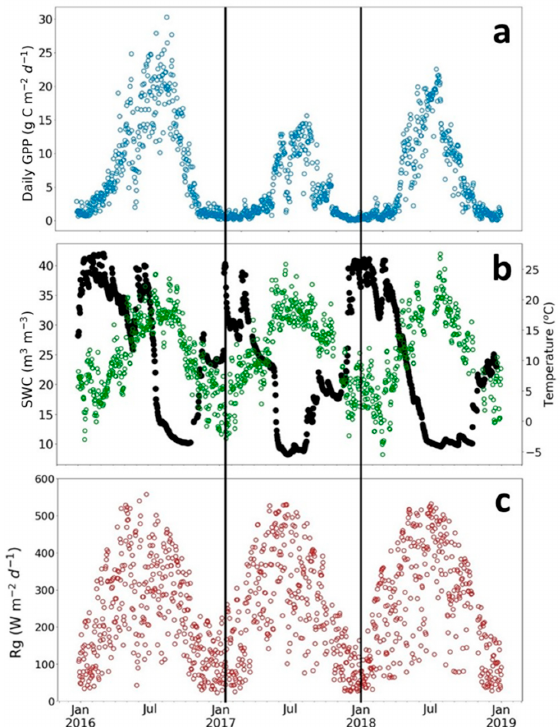
Figure 2. Seasonal variation of daily sums of Gross Primary Productivity (Daily GPP) and meteorological variables for three growing seasons at the poplar plantation in Lochristi. ( a ) Daily GPP in gC m − 2 d − 1 ; ( b ) soil water content (SWC in m 3 m − 3 , black dots) and air temperature (green dots); and ( c ) global radiation (Rg in W m − 2 d − 1 ).